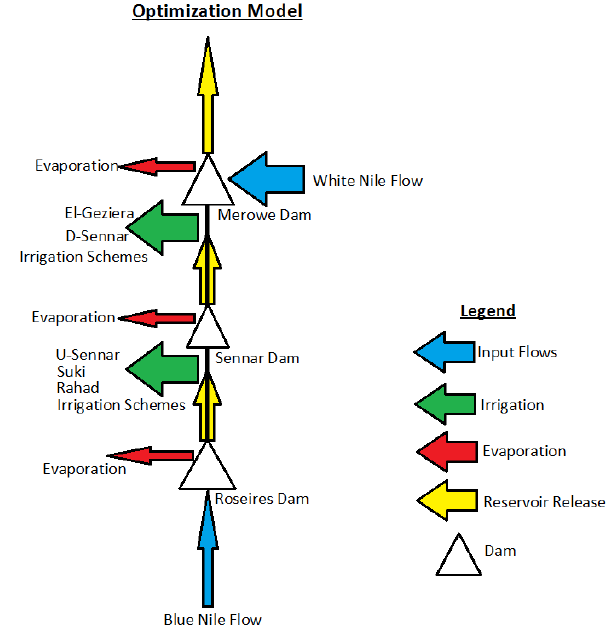
Figure 2. Schematic of the optimization model.